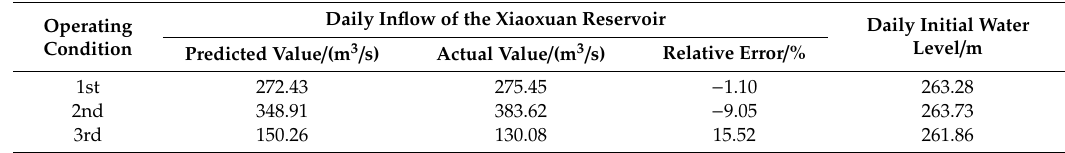
Table 1. Information about each operating condition.